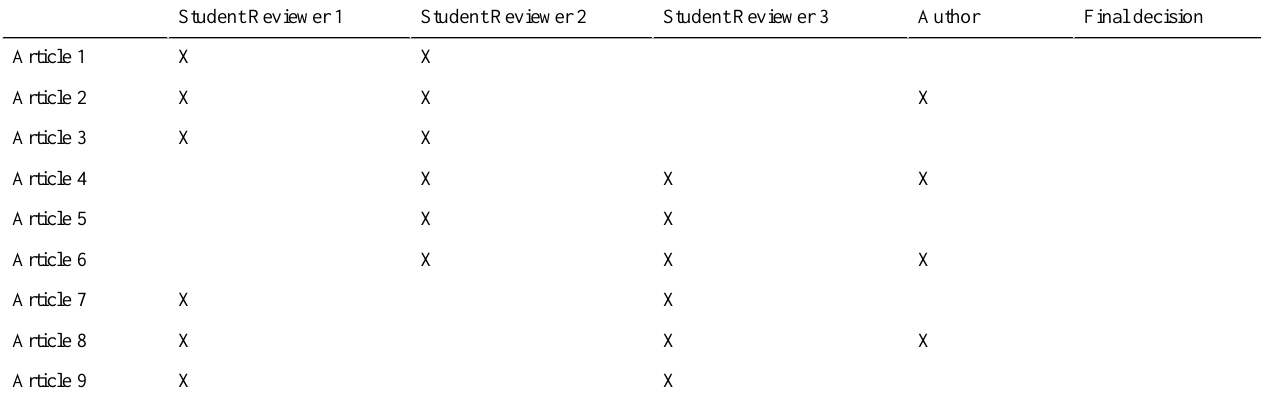
Table 1. Division of workload. “X” indicates which article is being